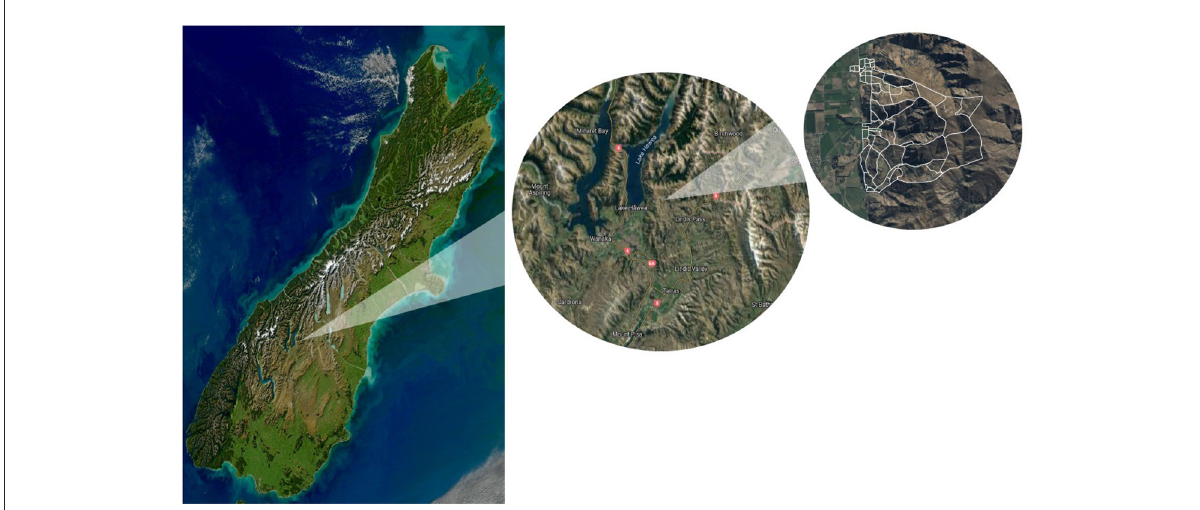
FIGURE2 The geographic location of Lincoln University Mount Grand Station (LUMGS), latitude 44 ◦ 38 ′ 01.93"S; longitude 169 ◦ 19 ′ 42.89"E, and paddocks boundary. From left to right: The South Island of New Zealand, Lake Hawea in Central Otago, and the paddocks boundary of the station.